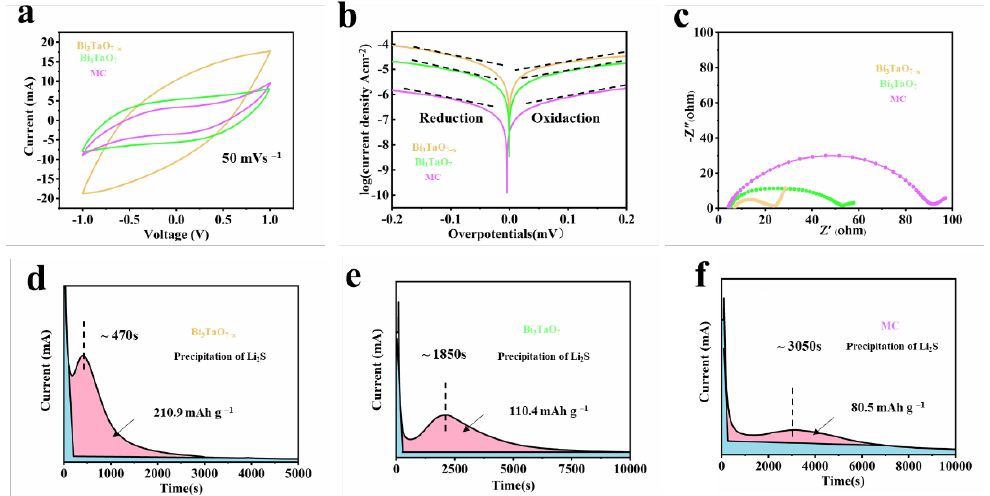
Figure 5. ( a ) Cyclic voltammetry curves for Li 2 S 6 symmetric cells employing Bi 3 TaO 7 − x and Bi 3 TaO 7 . ( b ) Tafel plots of Li 2 S 6 symmetric cells. ( c ) EIS spectra of Li 2 S 6 symmetric cells. ( d – f ) Precipitation profiles of Li 2 S.